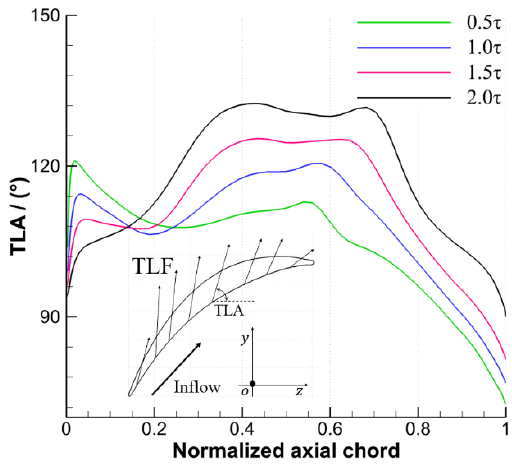
Figure 13. Tip leakage flow angle distributions at